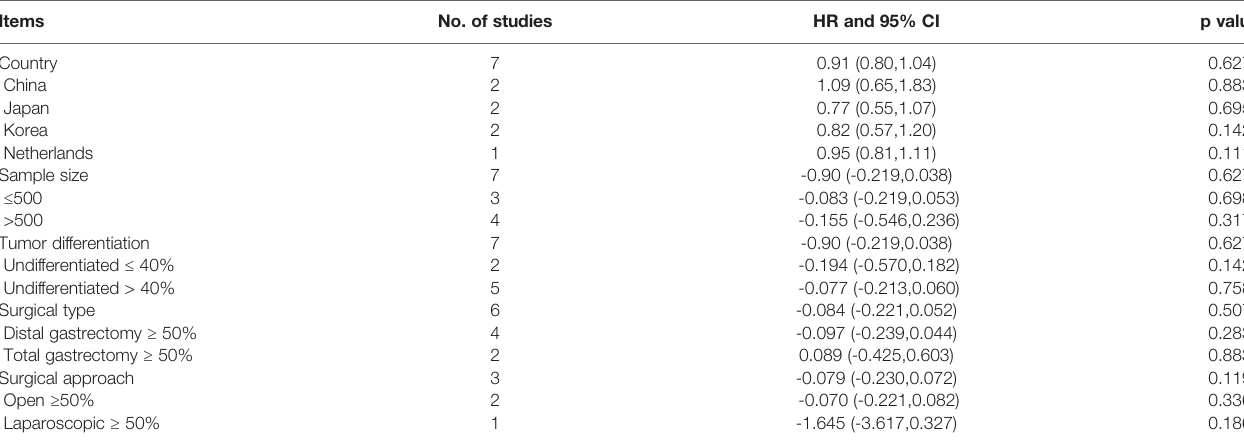
TABLE 2 | Subgroup analysis of